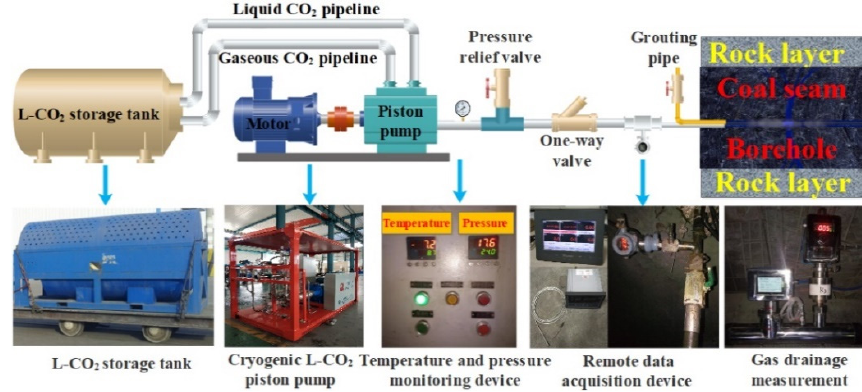
Figure 1. Schematic of the cryogenic L-CO 2 cyclic injection system and equipment.